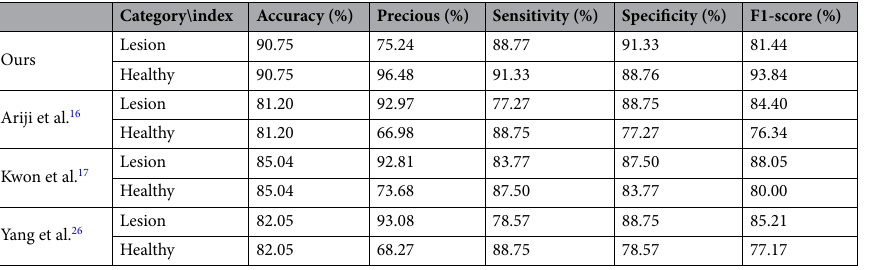
Table 2. The binary classification performance of lesion and healthy samples. Healthy samples achieve lower sensitivity/recall scores than lesion samples, which indicates that part of healthy samples tends to be classified as lesion samples. Our method achieves higher scores than the other three methods. The binary classification of our method achieves higher accuracy (90.66%) than the average accuracy score (88.72%) of the five-class classification in Table 1.